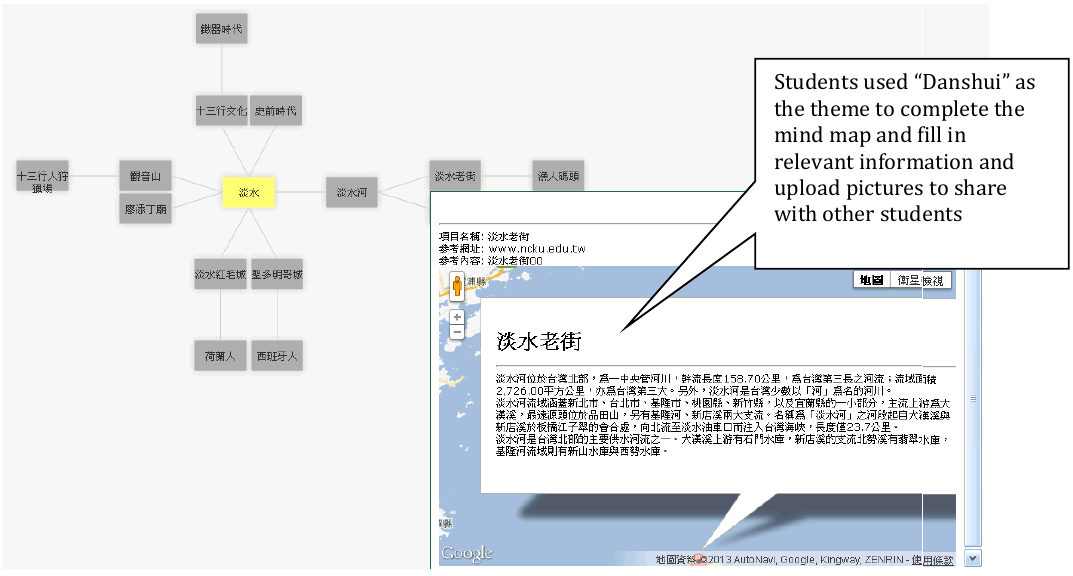
Figure 6. Development of the mind